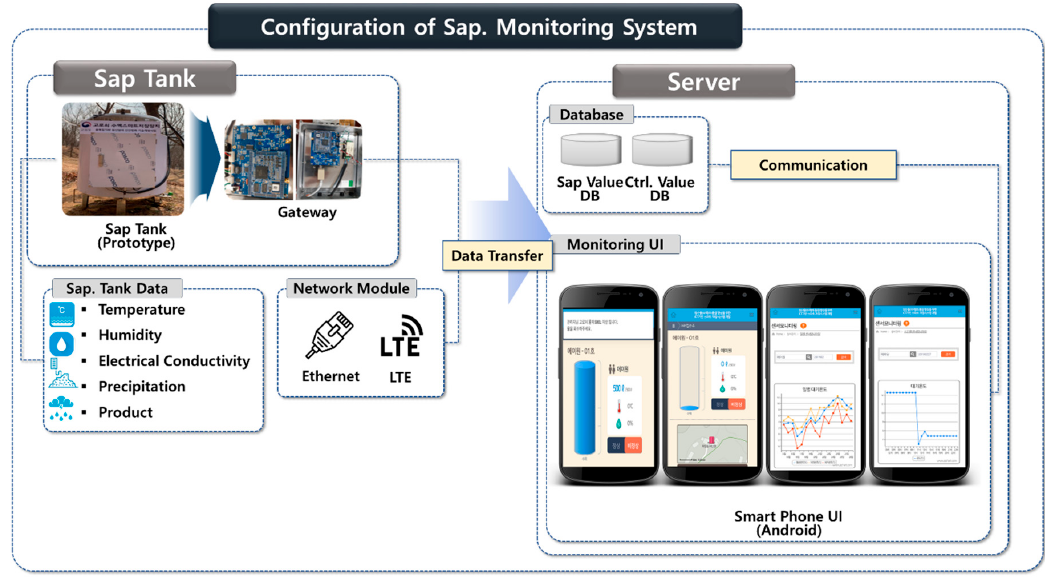
Figure 5. Block diagram of Acer mono sap monitoring.